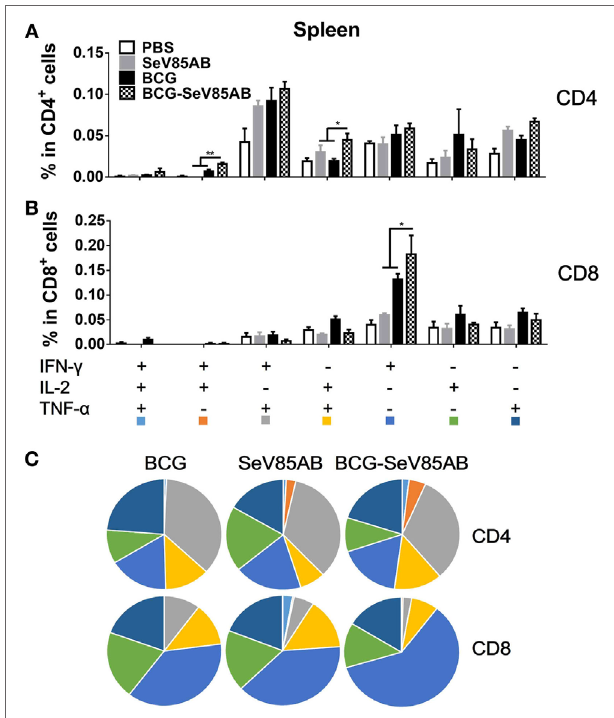
FigUre 3 | Characterization of poly-functional Ag85AB-specific T cell responses in the spleen. T cells producing IFN- γ , IL-2, and TNF- α were distinguished by ICS assay as seven subpopulations based on the production of these three cytokines in any combination. The percentage of subpopulations as components of the total CD4 + (a) or CD8 + (B) T cell population and the pie chart analysis (c) are shown. Significant differences in frequency of poly-functional T cell subsets are indicated. Data are representative of two independent experiments with at least four mice per group. * P < 0.05 and ** P <